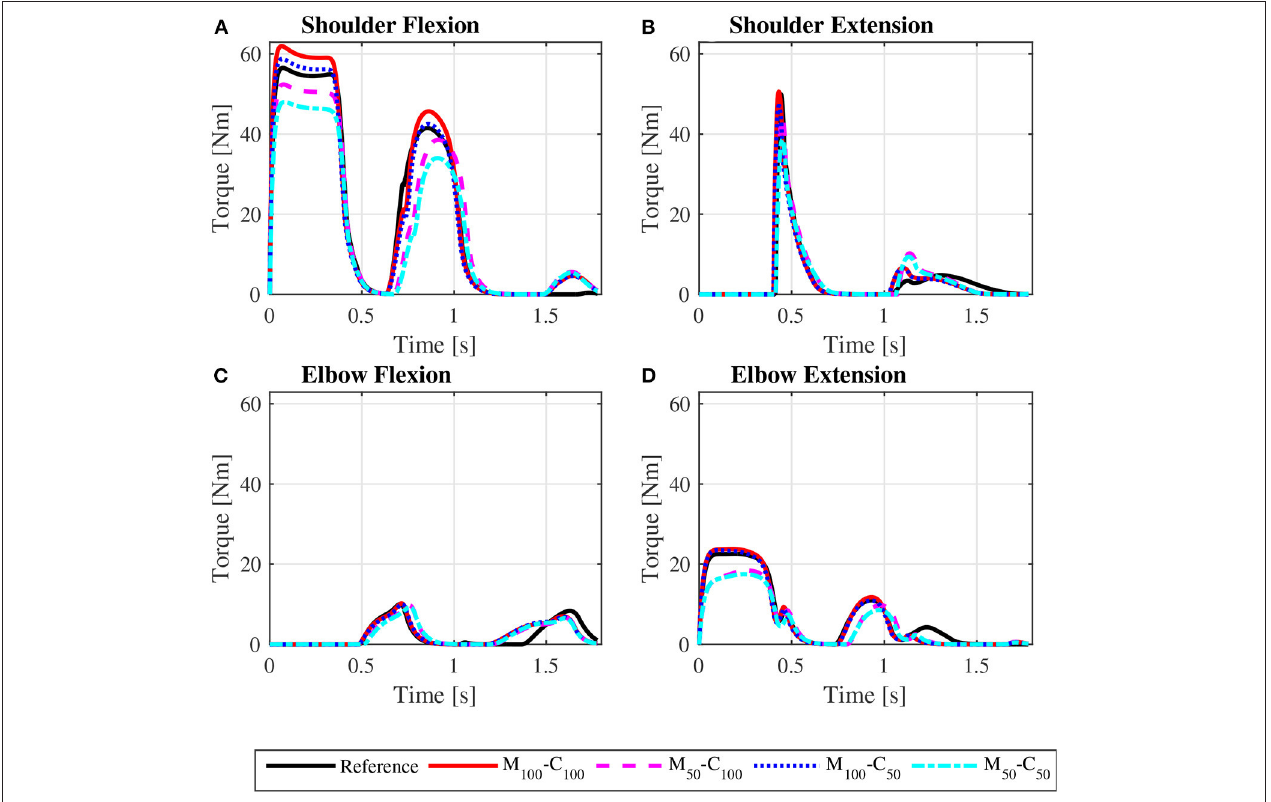
FIGURE 7 | Predicted bilateral shoulder flexion (A) , shoulder extension (B) , elbow flexion (C) , and elbow extension (D) torque profiles along the sequence of phases propulsion-recovery-propulsion-recovery-propulsion in the startup locomotion on a level surface at an average speed of 0.9 m/s for the reference unassisted condition (Reference), and for the assisted locomotion with 100% of reference model parameters Mi and Ci ( M 100 − C 100 ), reduction of 50% in Mi ( M 50 − C 100 ), reduction of 50% in Ci ( M 100 − C 50 ), and reduction of 50% in Mi and Ci ( M 50 − C 50